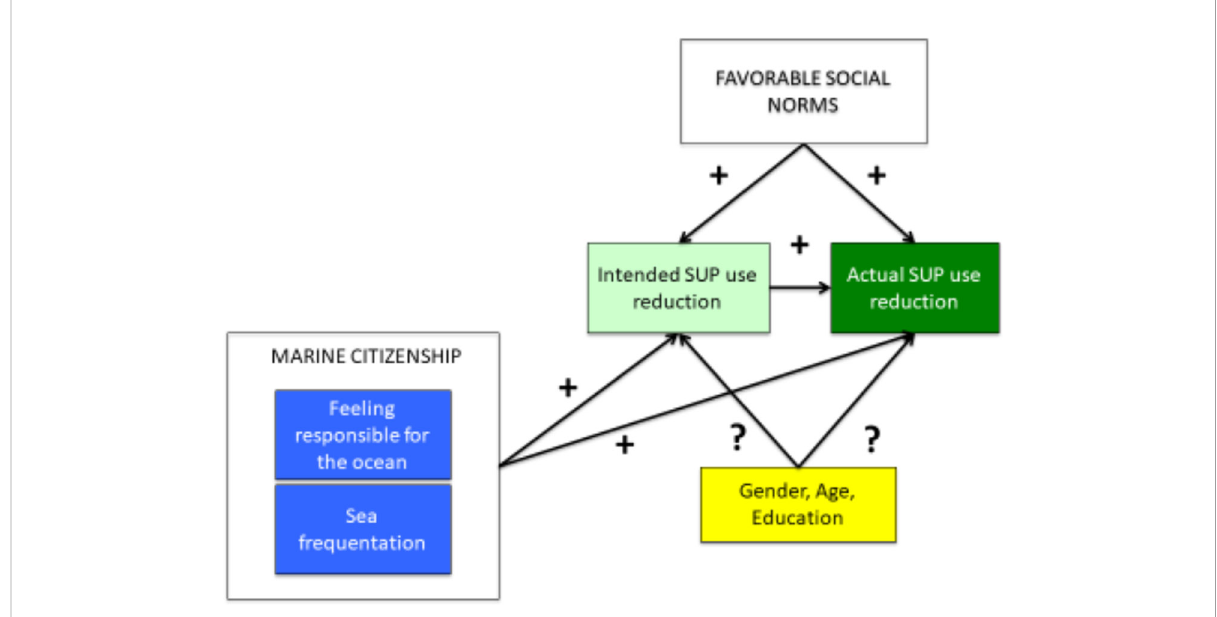
FIGURE 1 Graphical summary of the model tested in this study. Arrows represent relationships between variables. The sign of the expected relationship is